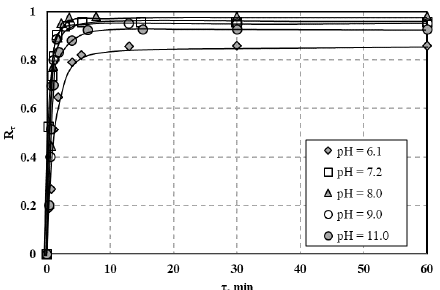
Figure A7. Changes in Al(III) temporary removal ratio during ion and precipitate flotation from solution containing Al(III), Cu(II), and Zn(II) mixture—effect of pH (c 0 = 0.15 mmol dm − 3 , c SDS = 0.125, u G = 1.51 mm s − 1 ).